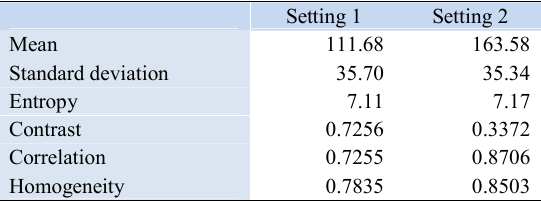
Table 1: Image analysis for an indicative image taken under different radiometric settings.